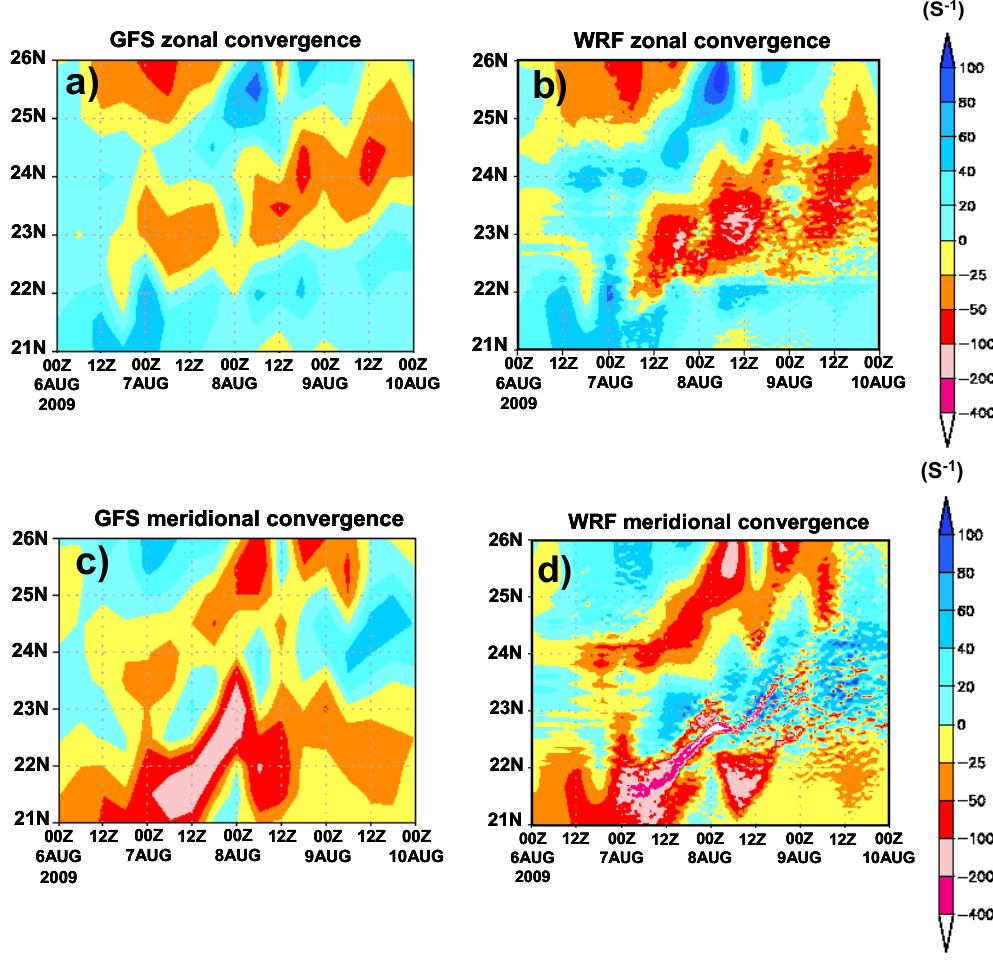
Fig. 5. (a) Temporal variation of wind convergence (negative) and divergence (positive) in E-W direction (colored) between 950 and 700hPa for the zonal mean (119–121 ◦ E) deduced from NCEP GFS data sets. (b) Simulated results of the temporal variation of wind convergence (negative) and divergence (positive) in E-W direction (colored) between 950 and 700hPa for the zonal mean (119–121 ◦ E) from WRF model. (c) Same as (a) but for N-S direction (colored) (d) Same as (b) but for N-S direction